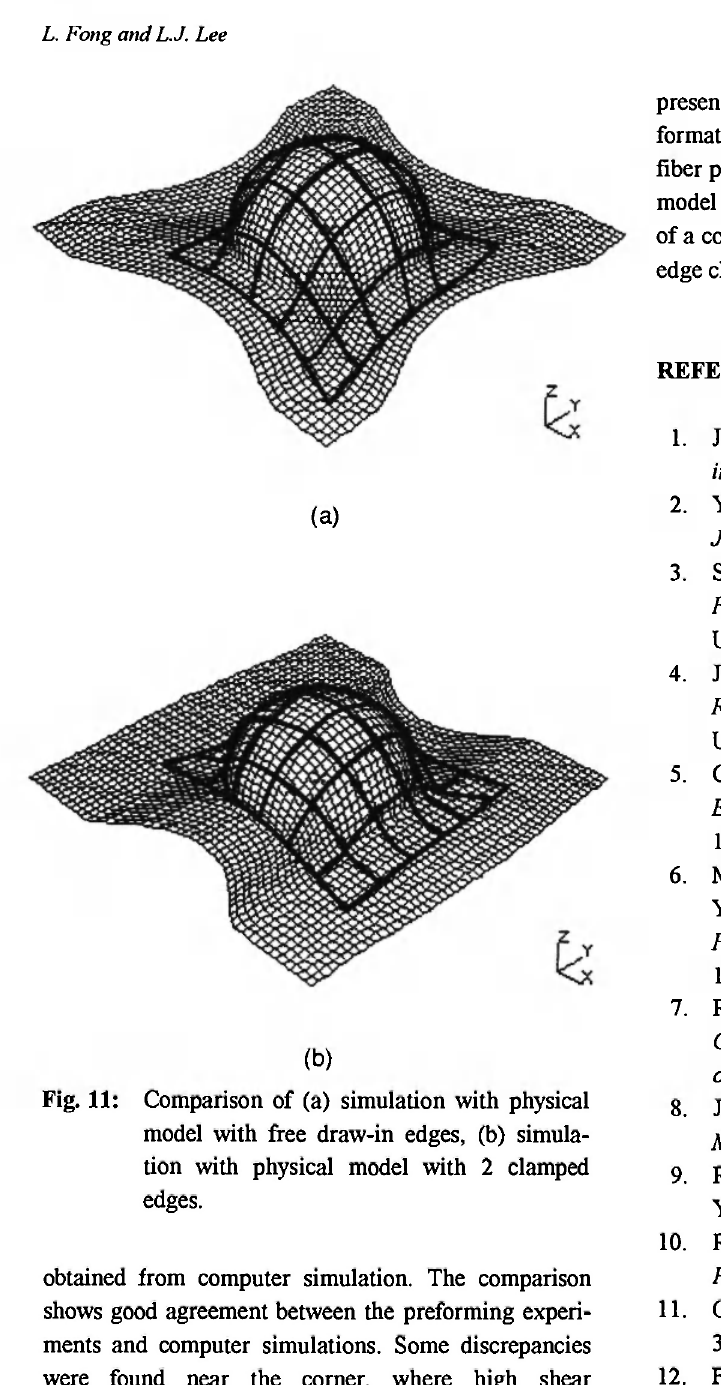
Fig. 11: Comparison of (a) simulation with physical model with free draw-in edges, (b) simula- tion with physical model with 2 clamped